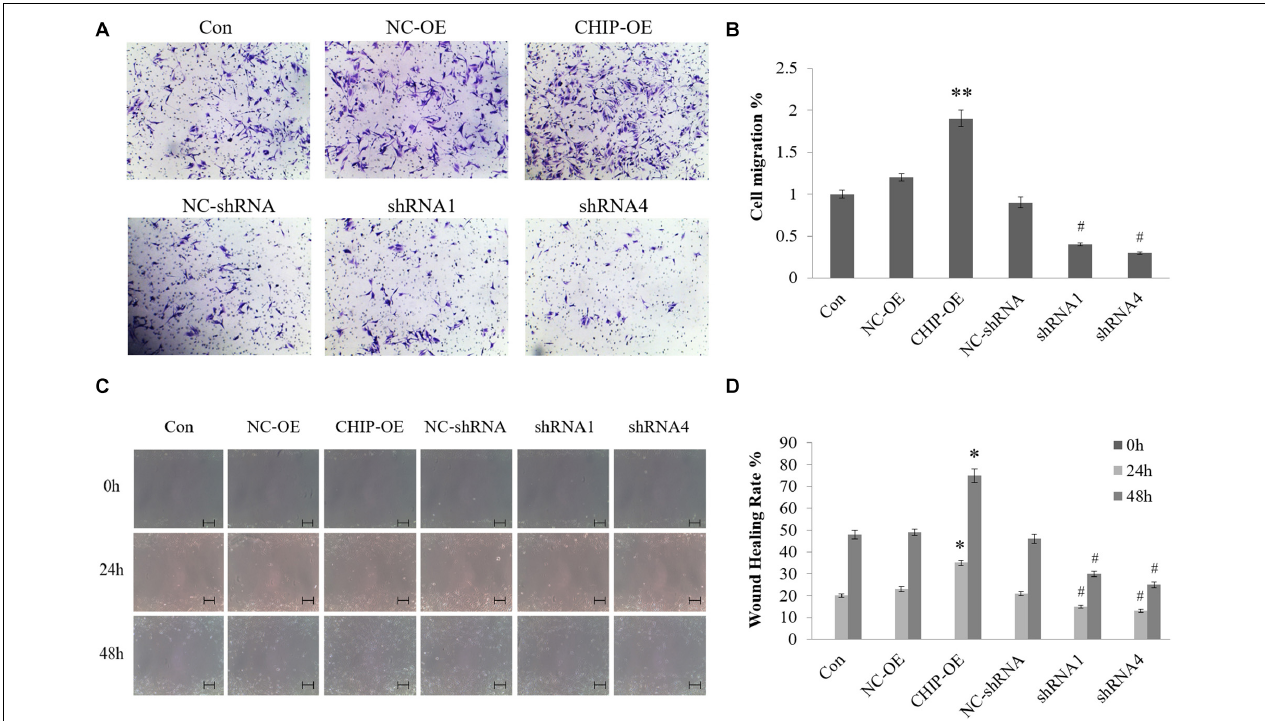
FIGURE 3 | C terminus of Hsc70-interacting protein (CHIP) overexpression enhanced cell migration and cell invasion after in vitro simulated traumatic brain injury. (A) Invasion capacity of the cells was evaluated by the transwell assay. Cells were stained with crystal violet and counted in five randomly selected microscopic fields. (B) Quantitative statistics of invasion capacity. ∗∗ p < 0.01 vs. the NC-OE, # p < 0.05 vs. the NC-shRNA. (C) Migration capacity of the cells was evaluated by the wound healing test. 3 × 10 5 cells were seeded in the Bioflex 6-well plates for 12 h, followed by in vitro stretch-induced injury treatment. Wound healing was observed after 0, 24, and 48 h within the scrape line, and representative scrape lines were imaged. (D) Quantitative statistics of migration capacity. ∗ p < 0.05 vs. the NC-OE, # p < 0.05 vs. the NC-shRNA. Scale bars: 50 µ m.